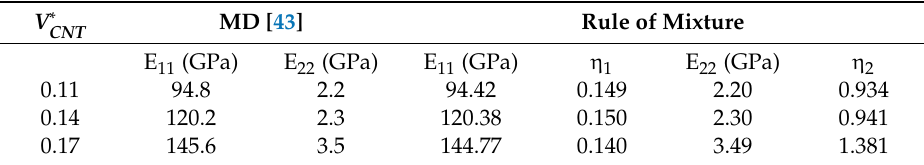
Table 1. Mechanical properties for a